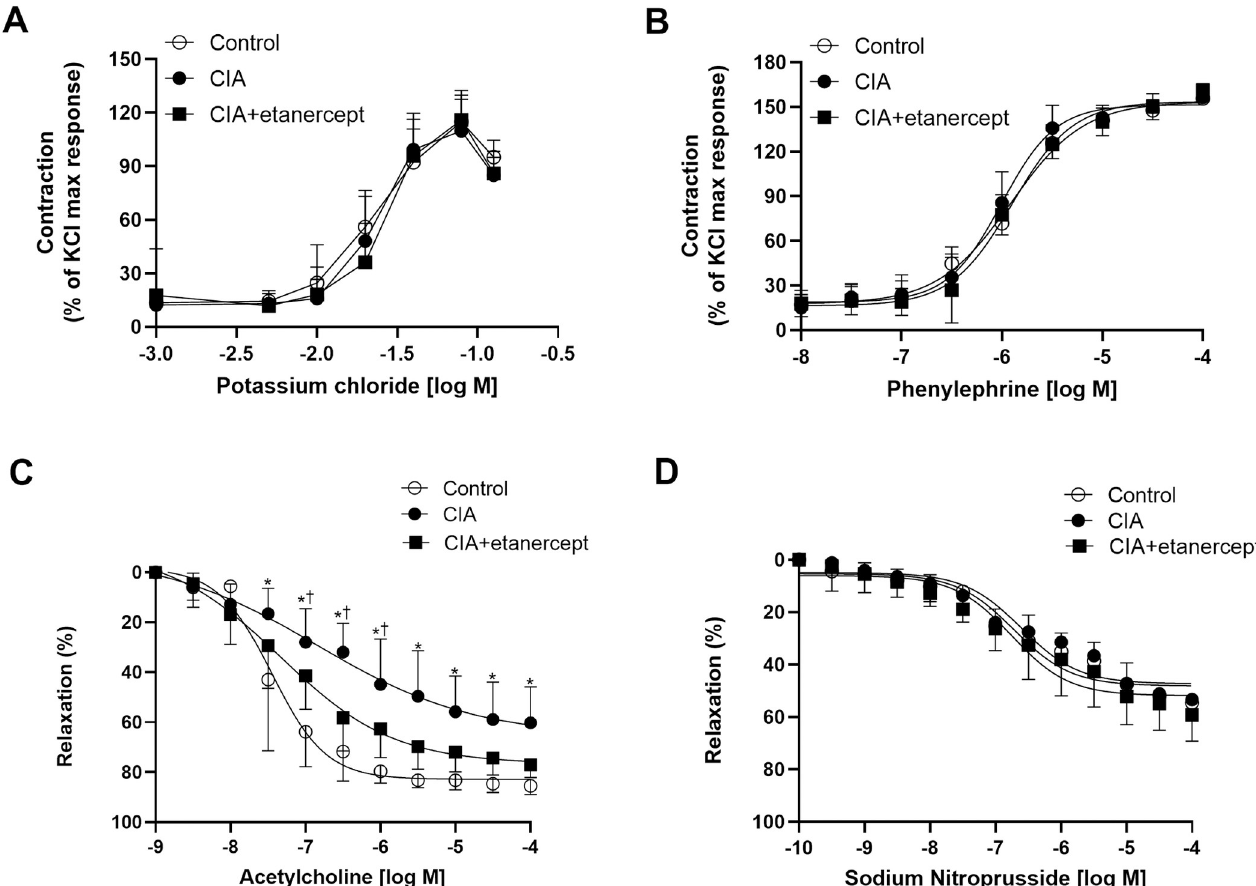
Fig 2. The effects of inflammation and TNF- α inhibitor treatment on vessel responses to vasoactive substances. The cumulative dose-response curves to ( A ) potassium chloride, ( B ) phenylephrine (C) acetylcholine and (D) sodium nitroprusside in the second branch of mesenteric arteries, in control, CIA and CIA+etanercept groups. Contractile responses are expressed as a percentage of the KCl maximal response. Relaxation responses are expressed as a percentage of the Phe (10 μ M)-induced contraction. Data expressed as means ± SEM. � p < 0.01 control and CIA+etanercept versus CIA, † p < 0.05 CIA+etanercept versus control; using repeated-measures ANOVA followed by Tukey post-hoc